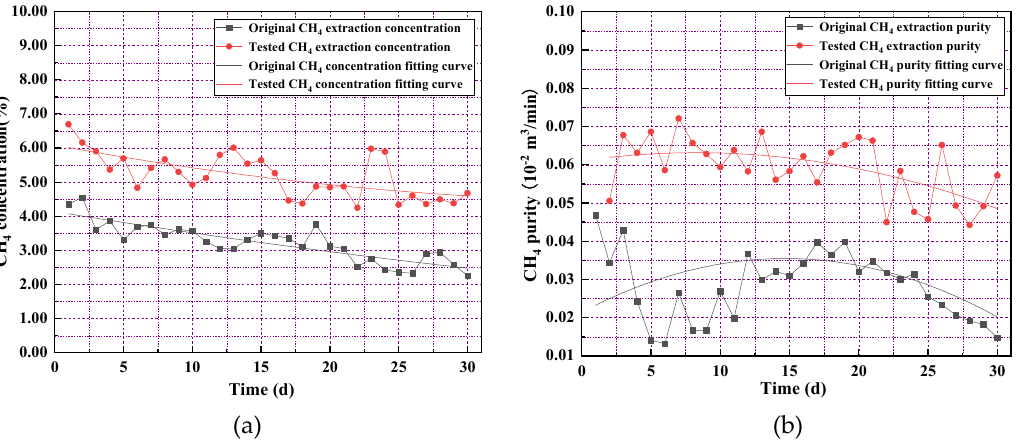
Figure 11. Average gas drainage concentration and drainage purity during low-pressure injection ( a ) Average gas drainage concentration and ( b ) Average gas drainage purity.